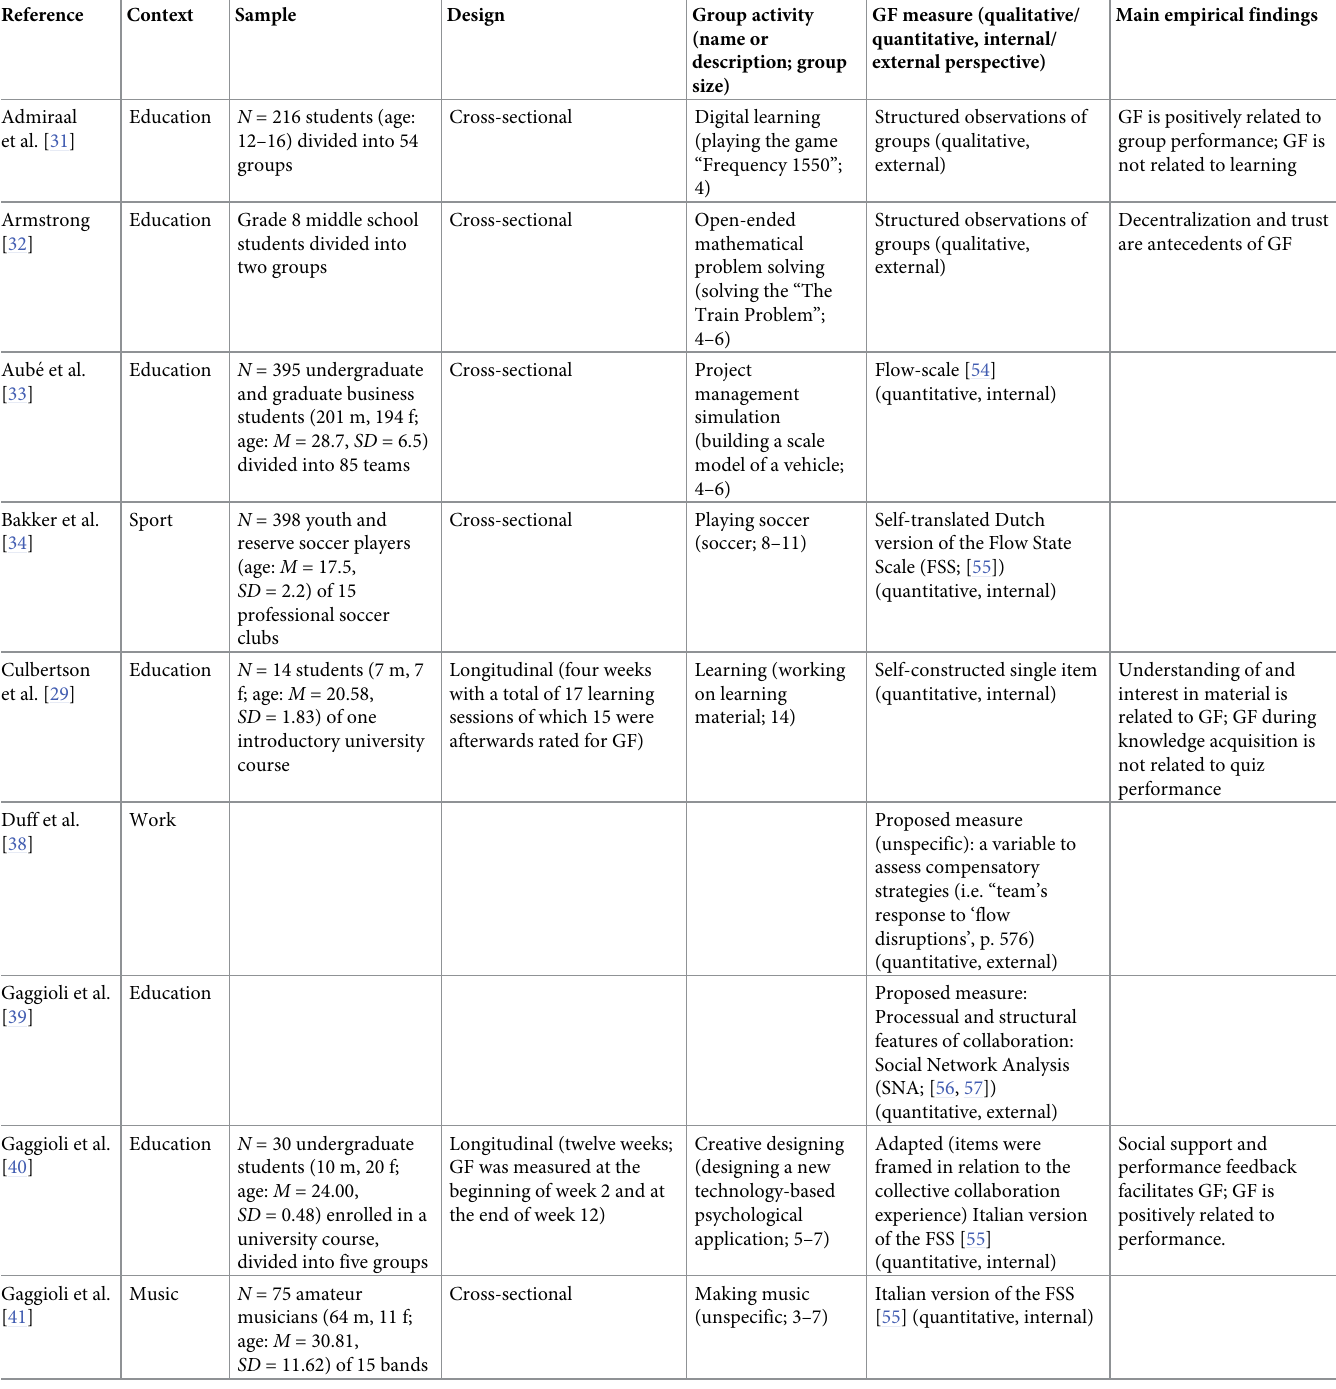
Table 2. Summary of empirical information on reviewed